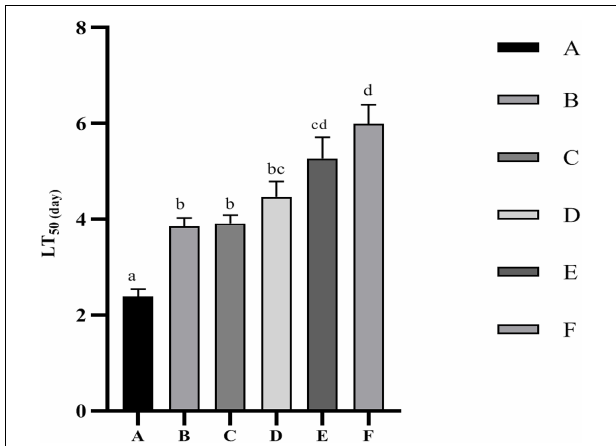
FIGURE 2 | Time to 50% mortality (LT 50 ) of P. monodon after infected with Vibrio parahaemolyticus . Data are expressed as mean ± SEM from triplicate groups. Different letters indicate significant ( p < 0.05) differences among various